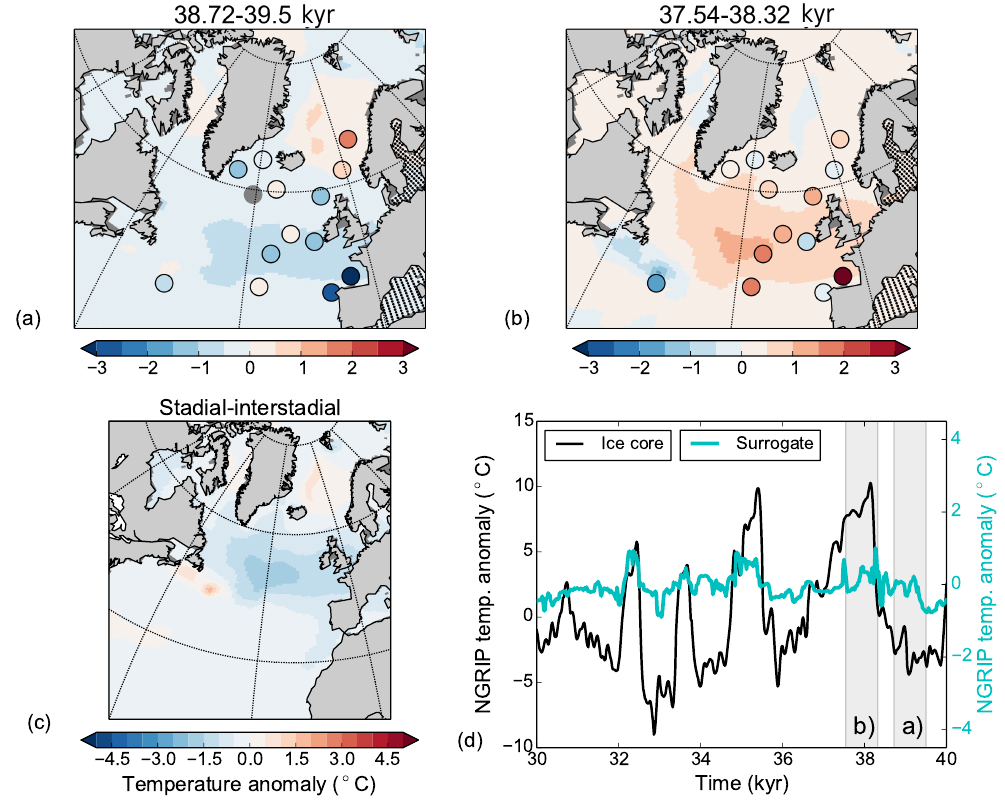
Figure 9. Same as Fig. 7 but for CCSM4